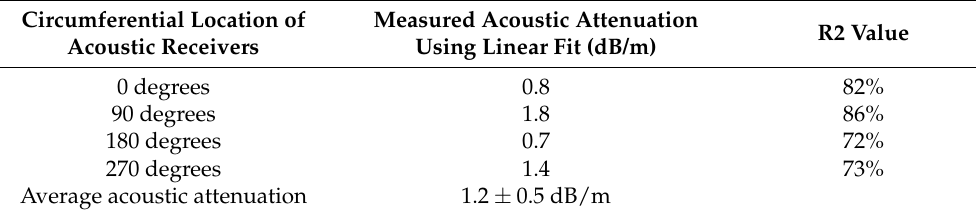
Table 3. Average SNR (dB) at each circumferential position around and axial distance along the exposed (empty) MDPE pipe.